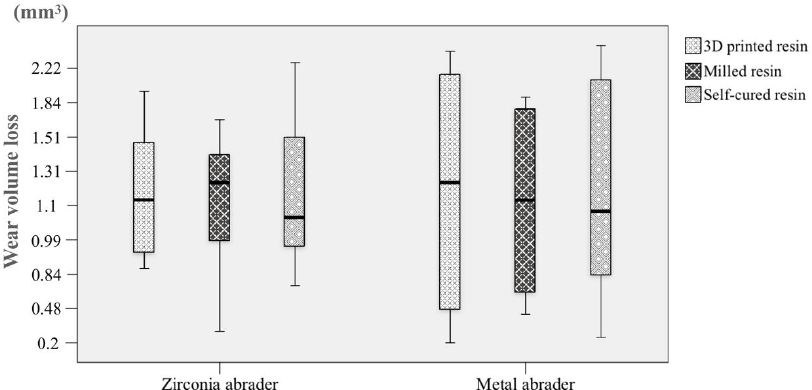
Figure 3. The wear volume loss of the materials against the zirconia and the metal abraders. The length of the box represents the interquartile ranges (IQRs) and the horizontal black line in the box stands for the median. The vertical lines extend to the maximum and minimum values.